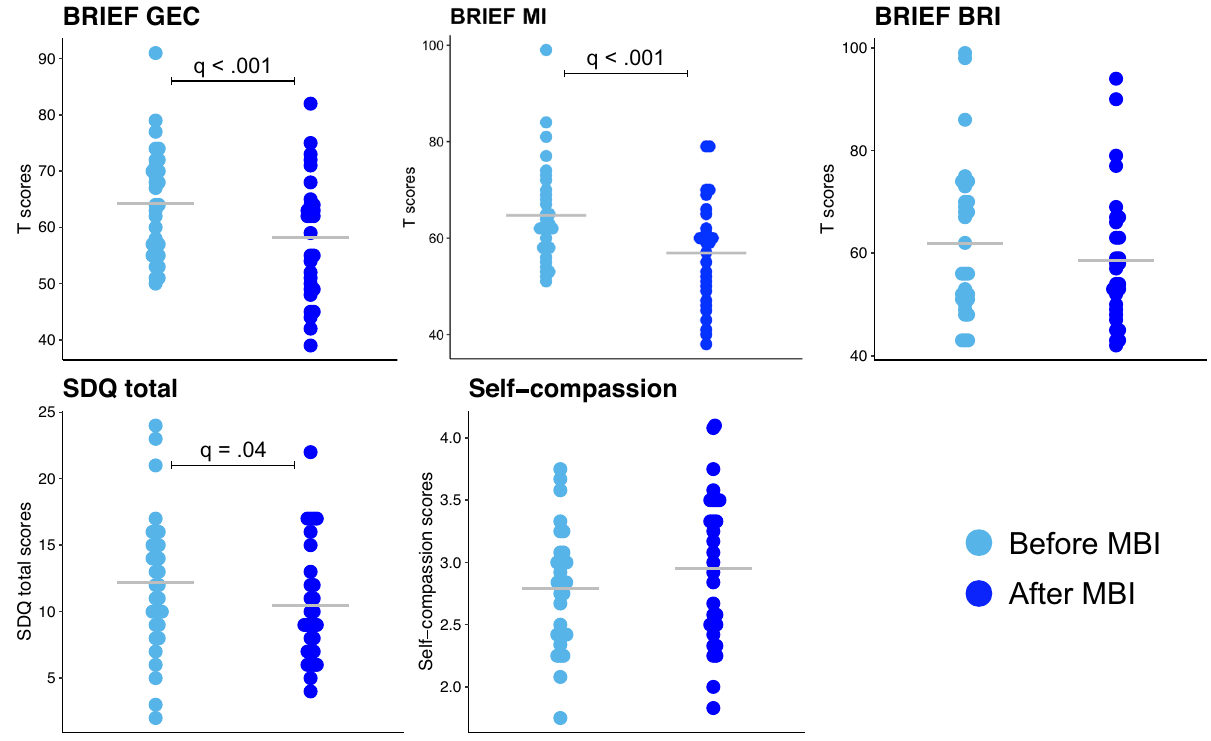
Figure 5. Neurobehavioural scores before and after MBI. Paired-sample t-tests was used to compared scores before and after MBI (FDR, q values < 0.05). The mean for each measure and each group is represented by a grey